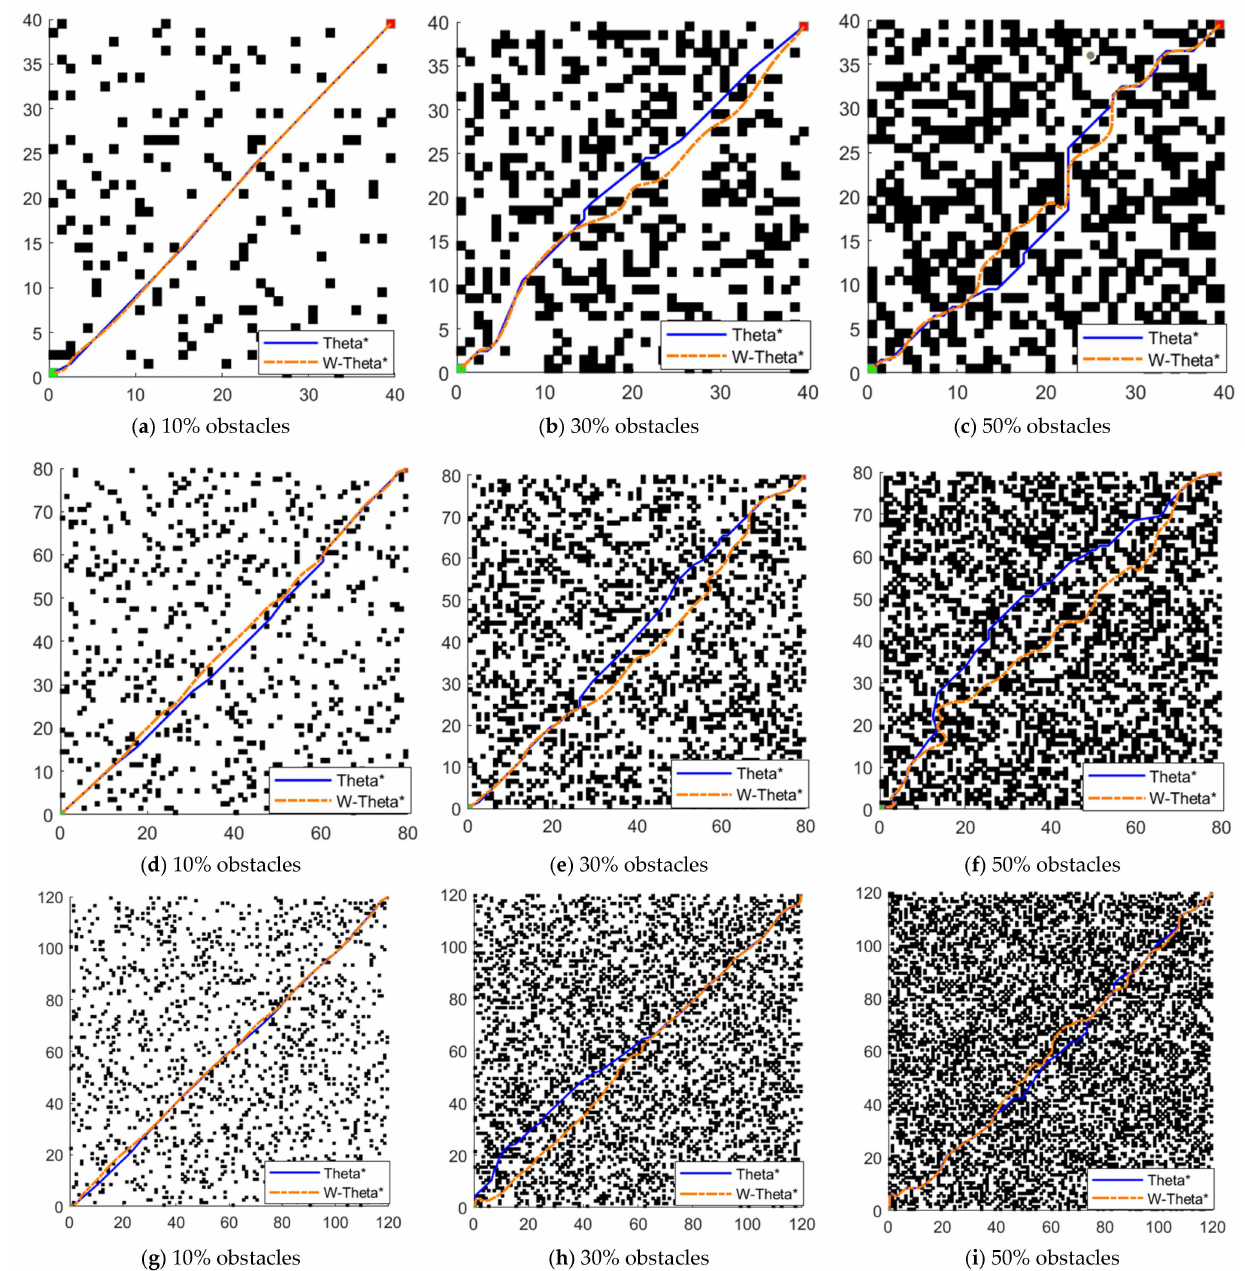
Figure 5. Comparison between W-Theta* algorithm and Theta* algorithm for maps with three sizes and different obstacle